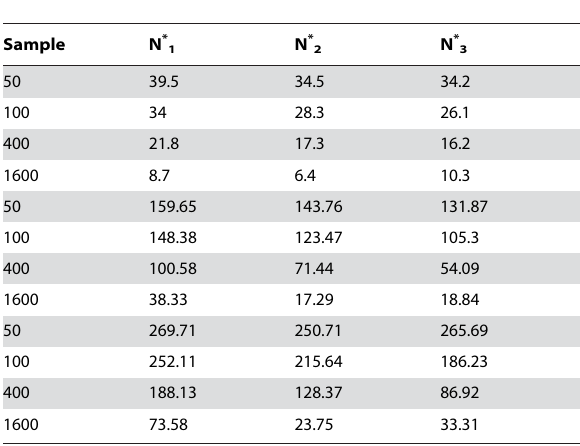
Table 2. Accuracy of estimators of the number of different haplotypes measured by the root of the mean squared error assessed by 100